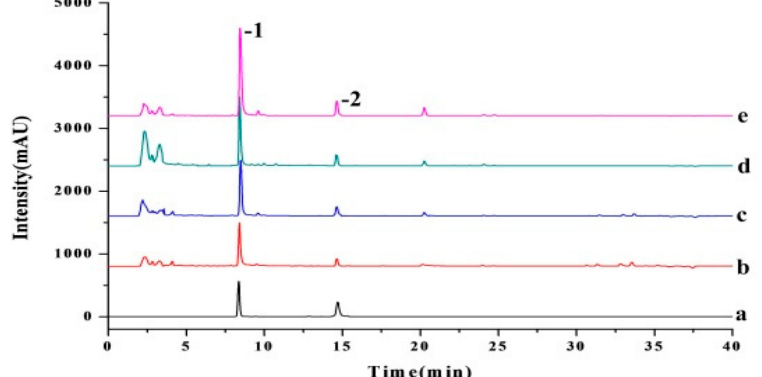
Figure 12 . Comparison of different extraction methods for extraction of AME and HIN from S. sinensis. ( a ) mixed standards; ( b ) Soxhlet extraction; ( c ) Percolation extraction; ( d ) MAE-ethanol; ( e ) MAE-IL; The peaks marked with 1, 2, which were AME and HIN, respectively.